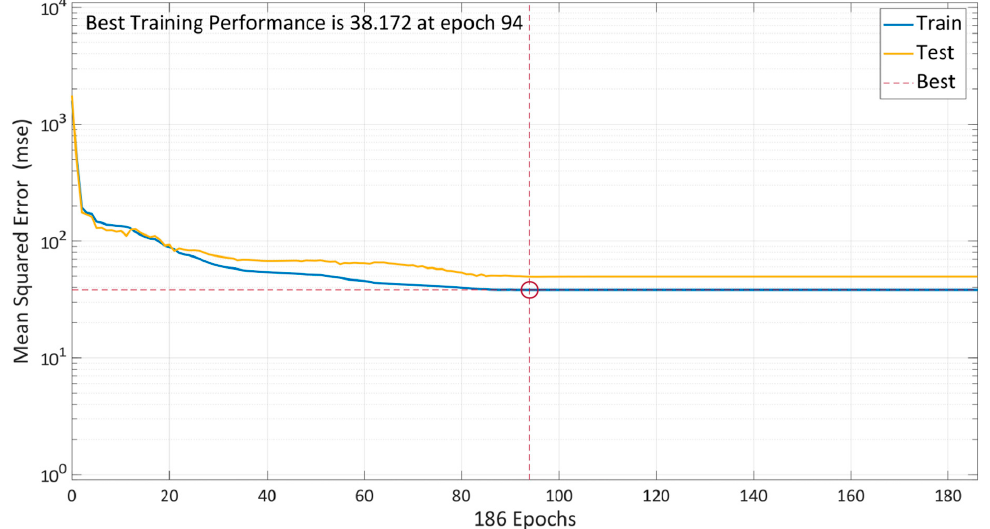
Figure 12. Model performance using BR